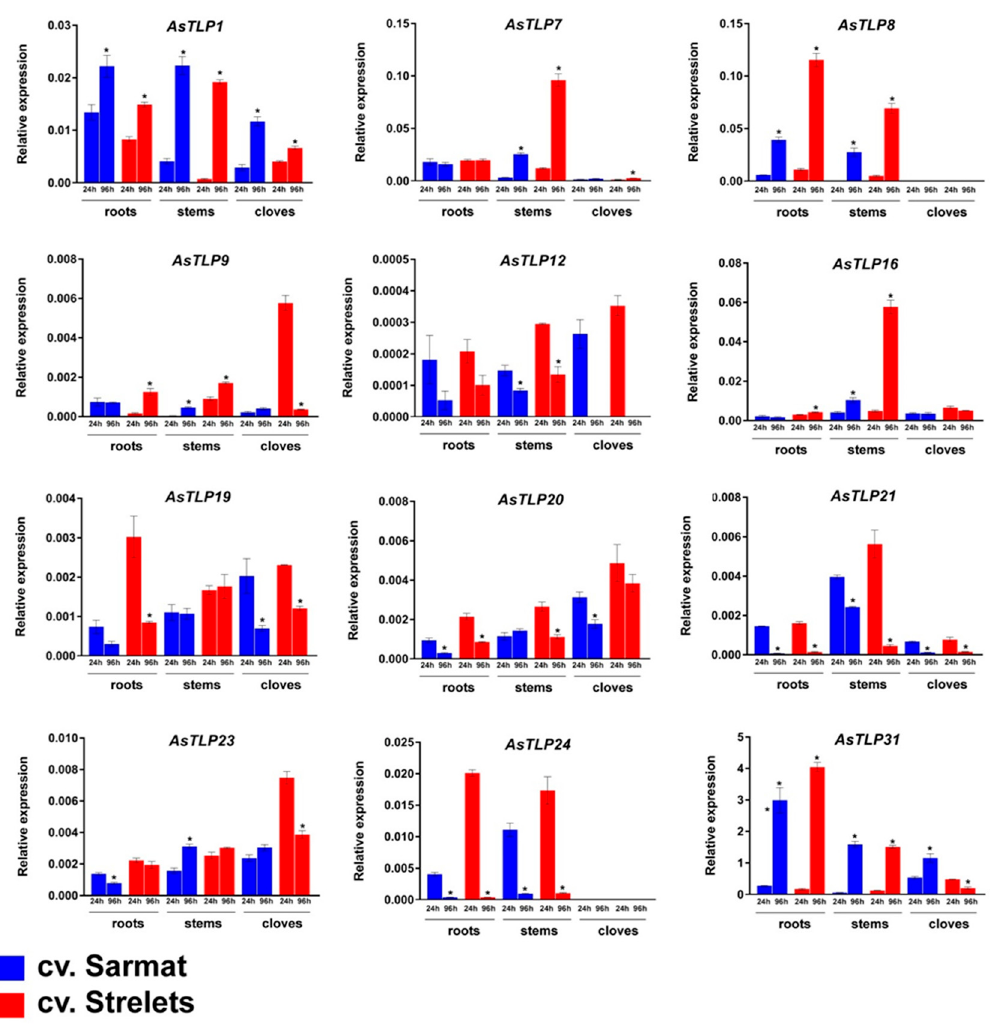
Figure 7. Time-dependent expression of AsTLP genes in the roots, stems (basal plates), and cloves of uninfected garlic cultivars resistant (cv. Sarmat) and susceptible (cv. Strelets) to FBR. The data were normalized to GAPDH and UBQ mRNA levels and presented as the mean ± SE ( n = 3); * p < 0.01 indicates the difference between 24 and 96 h.